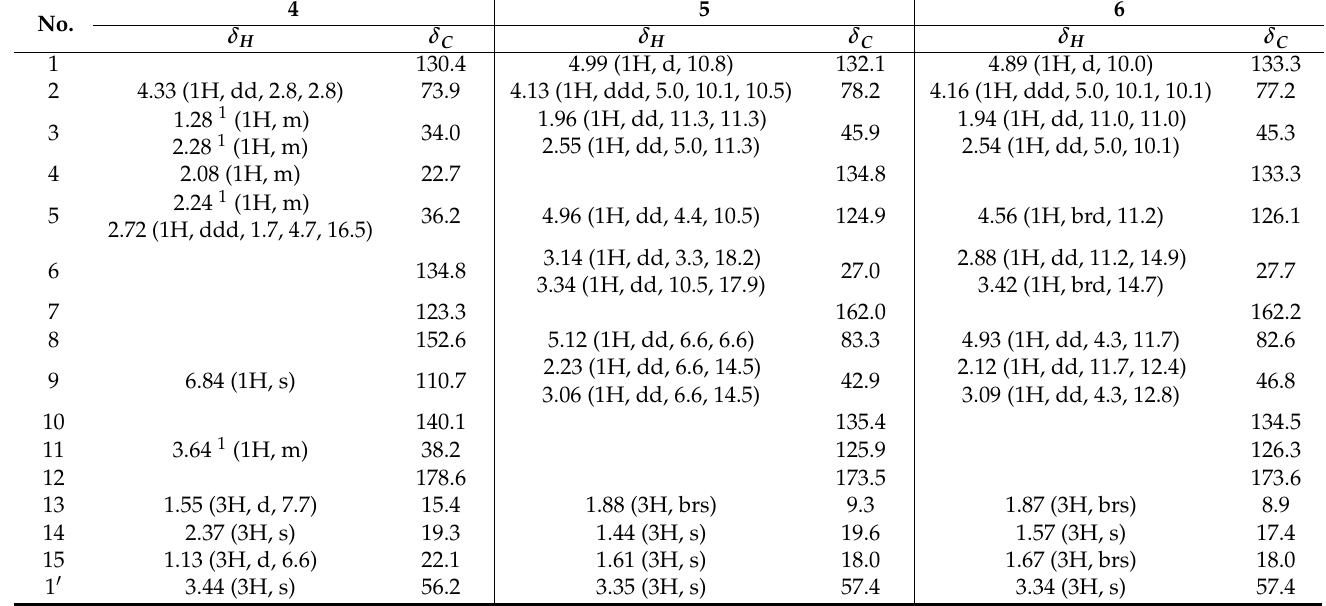
Table 2. 1 H and 13 C NMR data for compounds 4 , 5 (600 and 150 MHz, respectively) and 6 (400 and 100 MHz, respectively) in CDCl 3 ( δ in ppm, J in Hz, s: singlet, d: doublet, br: broad, and m: